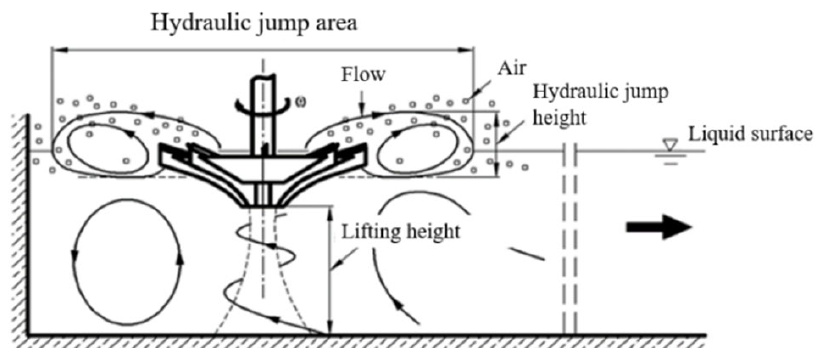
Figure 1. Diagram of the working principles of an inverted umbrella aerator.